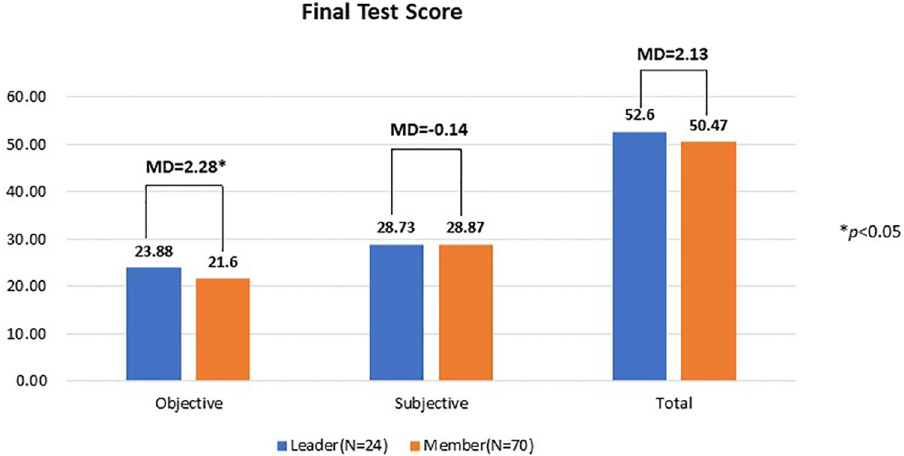
Fig 4. Mean difference in three types of test scores between leaders and